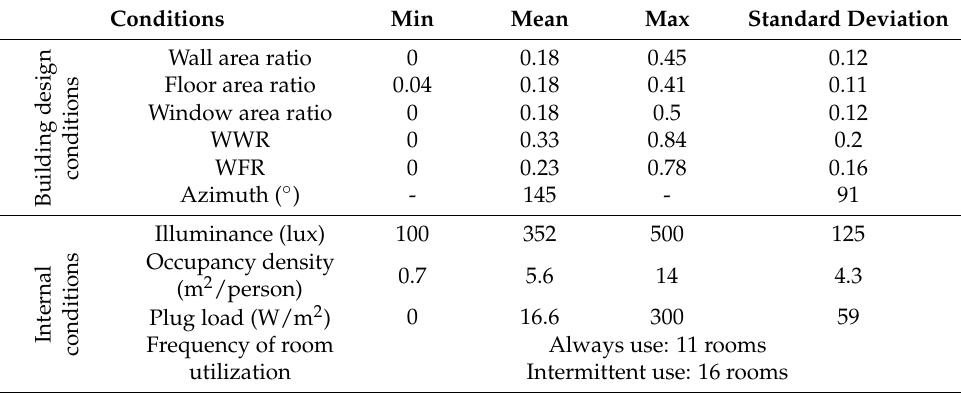
Table 5. Statistical information of the building and internal design conditions for each